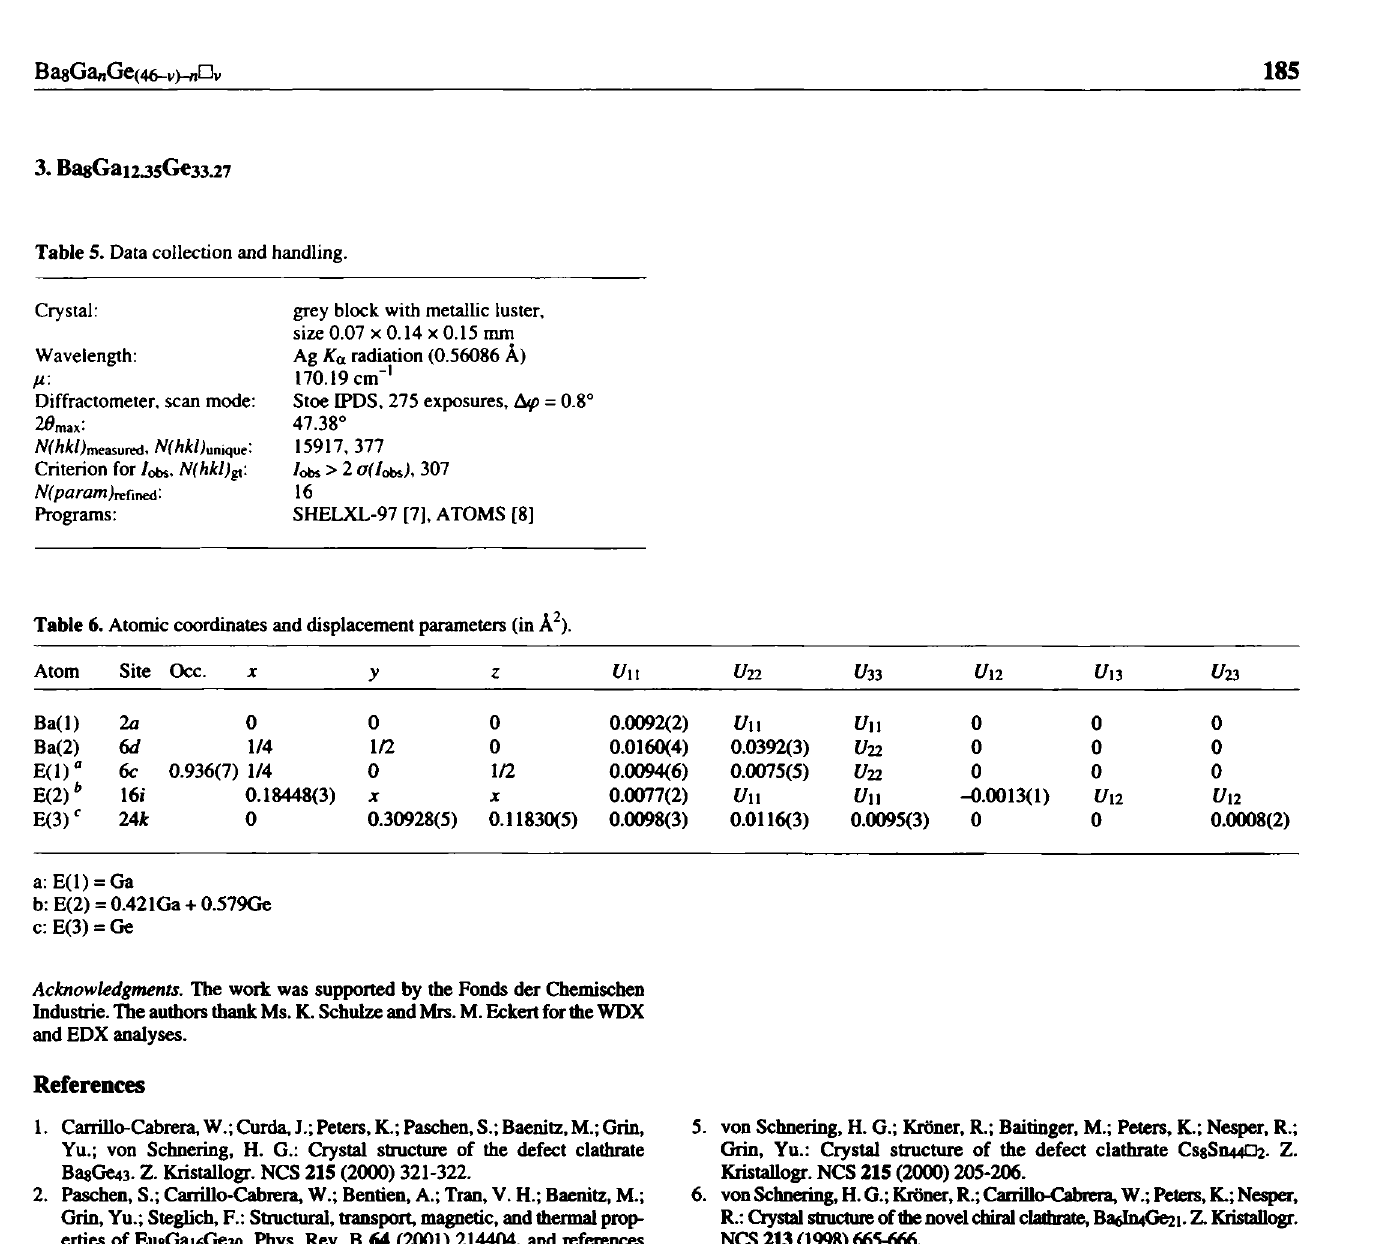
Table 5. Data collection and handling.